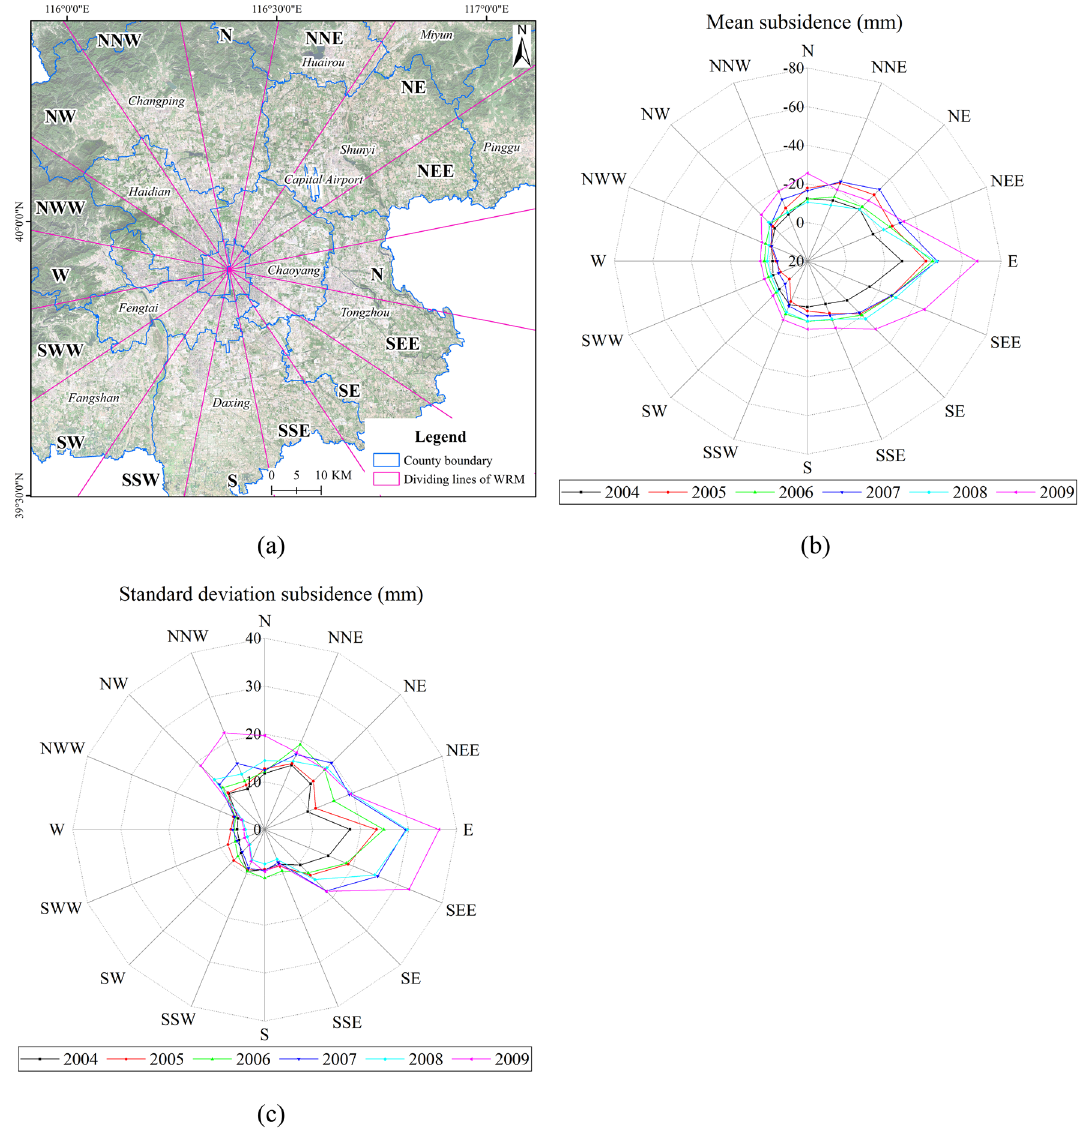
Figure 5. ( a ) WRM map of the mean subsidence in each subregion from 2004 to 2009. (Figure generated using ArcGIS v.10.6.0.8321, www. esri. com) ( b ) WRM map of the mean subsidence in each subregion from 2004 to 2009. ( c ) WRM map of the standard deviation subsidence in each subregion from 2004 to